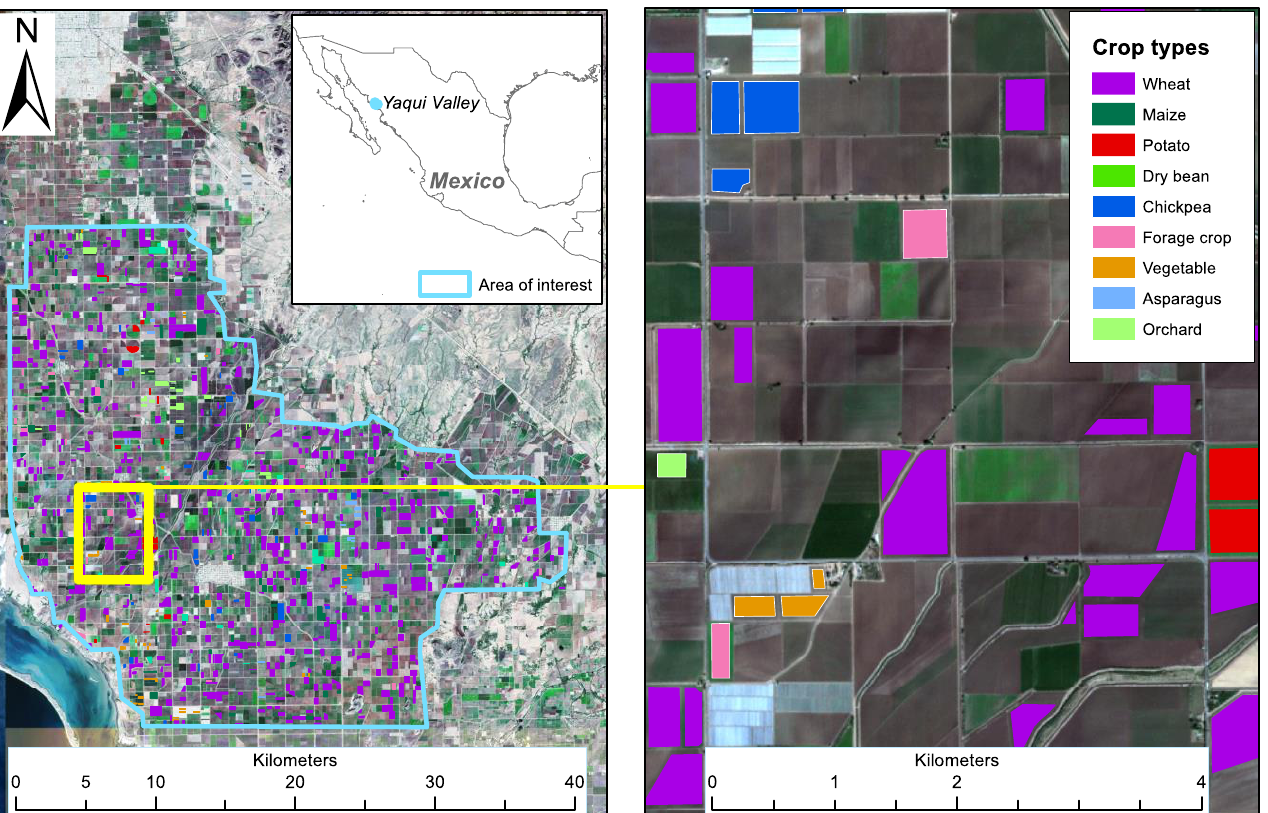
Figure 2. Overview of the study area located in the Yaqui Valley, Sonora, Mexico. The background imagery is a Sentinel-2 scene from 23 December 2016, displayed as red, green and blue. Within the area of interest, the boundaries of 6084 crop fields have been manually digitized. On the left side, the 876 fields are shown that were used to train the random forest classifier for the scenario Ratio-0.18, with a random seed of 0. The right side offers a more detailed view of the training and other crop fields.